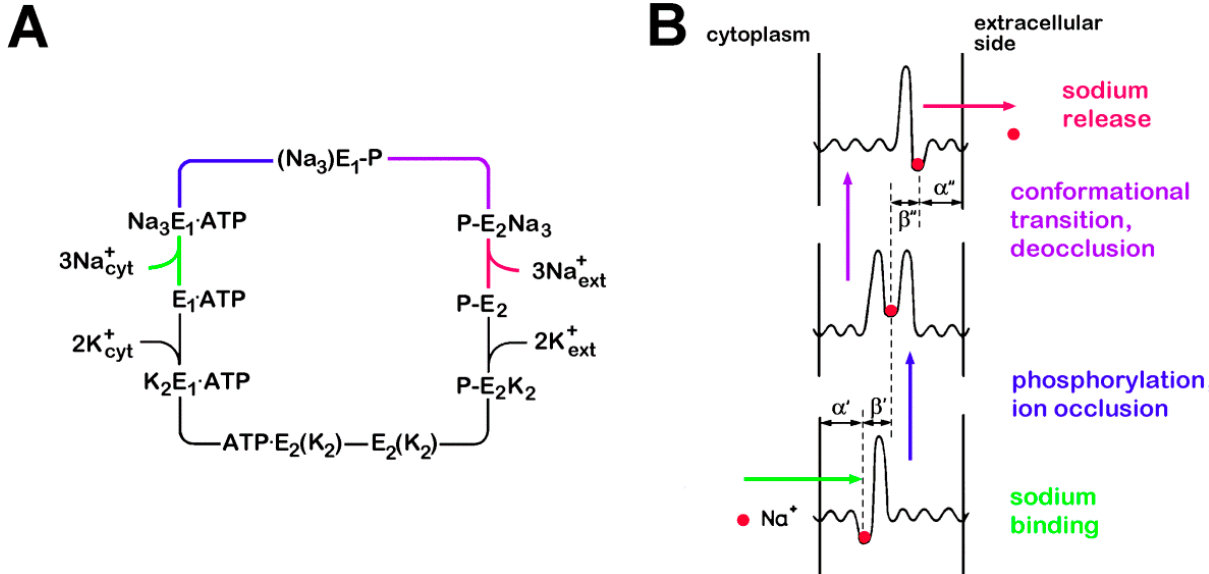
Figure 6. A: Post-Albers cycle of the Na,K-ATPase under physiological conditions. The Na + -transporting half cycle is subdivided in four partial reactions, Na + binding (green), enzyme phosphorylation by ATP, occlusion of 3 Na + , and release of ADP (blue), conformation transi- tion, E 1 -P to P-E 2 , and deocclusion of the binding sites to the extracellular side (magenta), and release of the Na + ions (red). B: Sequence of schematic energy profiles as detected by the ions during Na + -transport in three consecutive conformations as indicated in the pump cycle ( A ). The height of the energy barriers is schematic. This representation shall indicate that the high barriers are virtually impregnable for the ions with their available (thermal) energy. The quantities α’, α”, β’, and β” are so-called dielectric coefficients that describe the fraction of the electric potential traversed by an ion in the respective reaction step (for details see